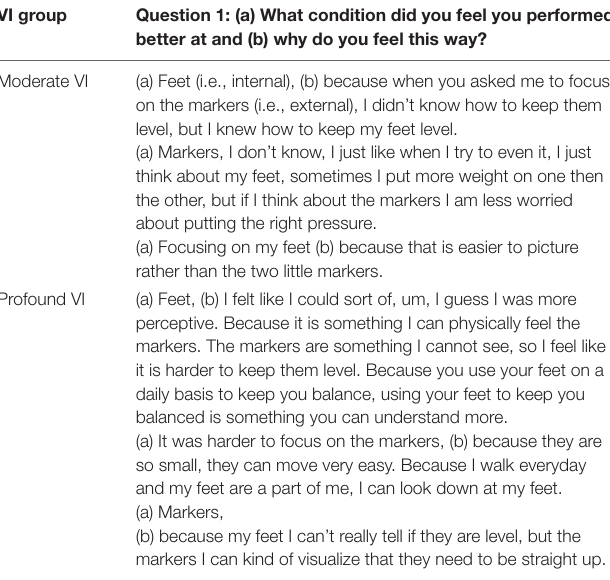
TABLE 2 | Open-ended questionnaire